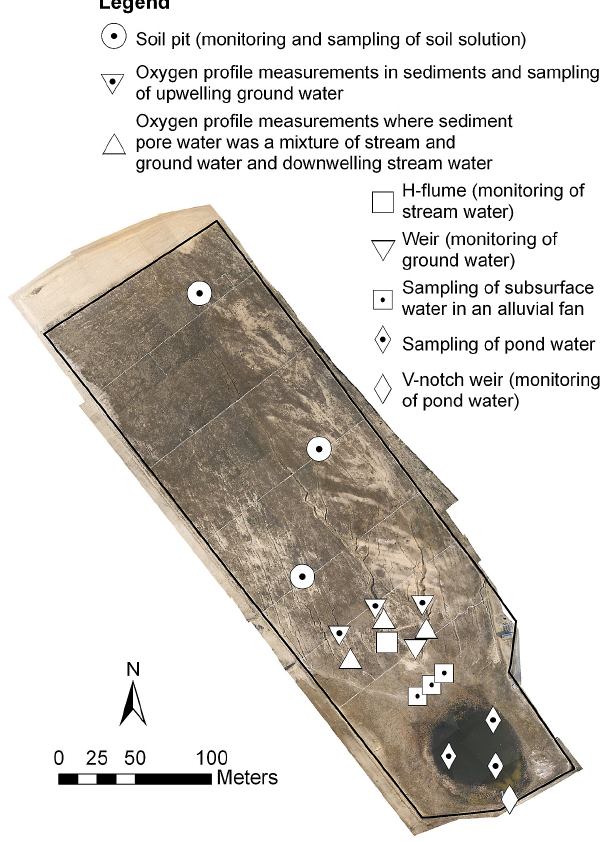
Fig. 1. Aerial photograph of the Chicken Creek Catchment taken in April 2010 with various kinds of sampling sites indicated by dif- ferent symbols. Solid black lines denote the catchment borders and gray lines are pathways to access the sampling sites of the otherwise undisturbed catchment. Density, depth and width of rills and gullies increase from northwest to southeast of the catchment, leading to the formation of three main streams. Dotted circle – soil pit (mon- itoring and sampling of soil solution), dotted downward pointing triangle – oxygen profile measurements in sediments and sampling of upwelling ground water, open upward pointing triangle – oxy- gen profile measurements where sediment pore water was a mixture of ground water and downwelling stream water, open square – H- flume (monitoring of stream water), open downward pointing trian- gle – weir (monitoring of ground water), dotted square – sampling of subsurface water in an alluvial fan, dotted rhombus – sampling of pond water, open rhombus – V-notch weir (monitoring pond